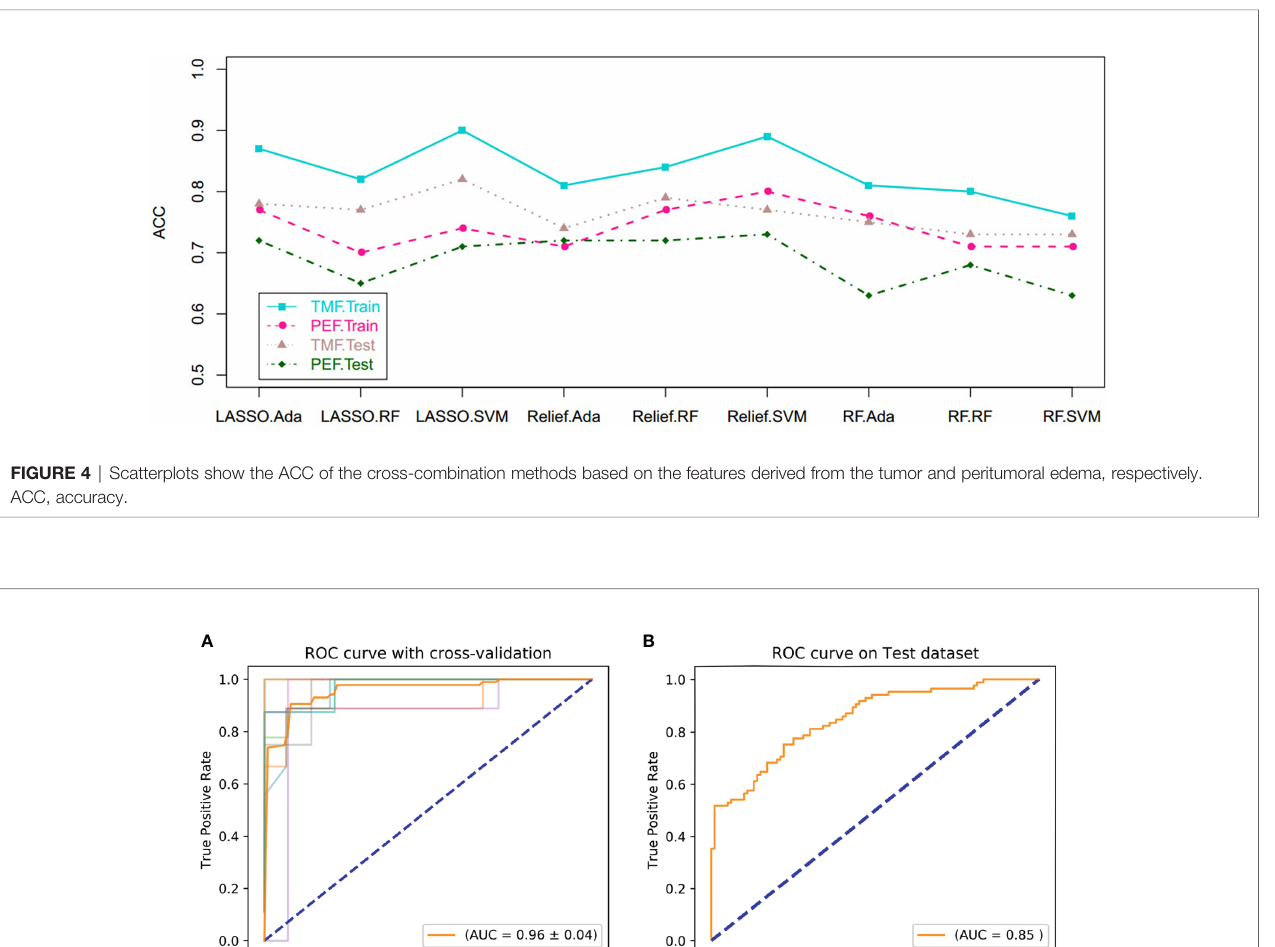
FIGURE 5 | ROC curve shows the optimal classi fi er for differentiating GSM from GBM. (A) The AUC of 5-fold cross-validated ROC is 0.96 in the training set. (B) The AUC of 5-fold cross-validated ROC is 0.85 in the validation set. AUC, area under the curve; GBM, glioblastoma; GSM, gliosarcoma; ROC, receiver operating